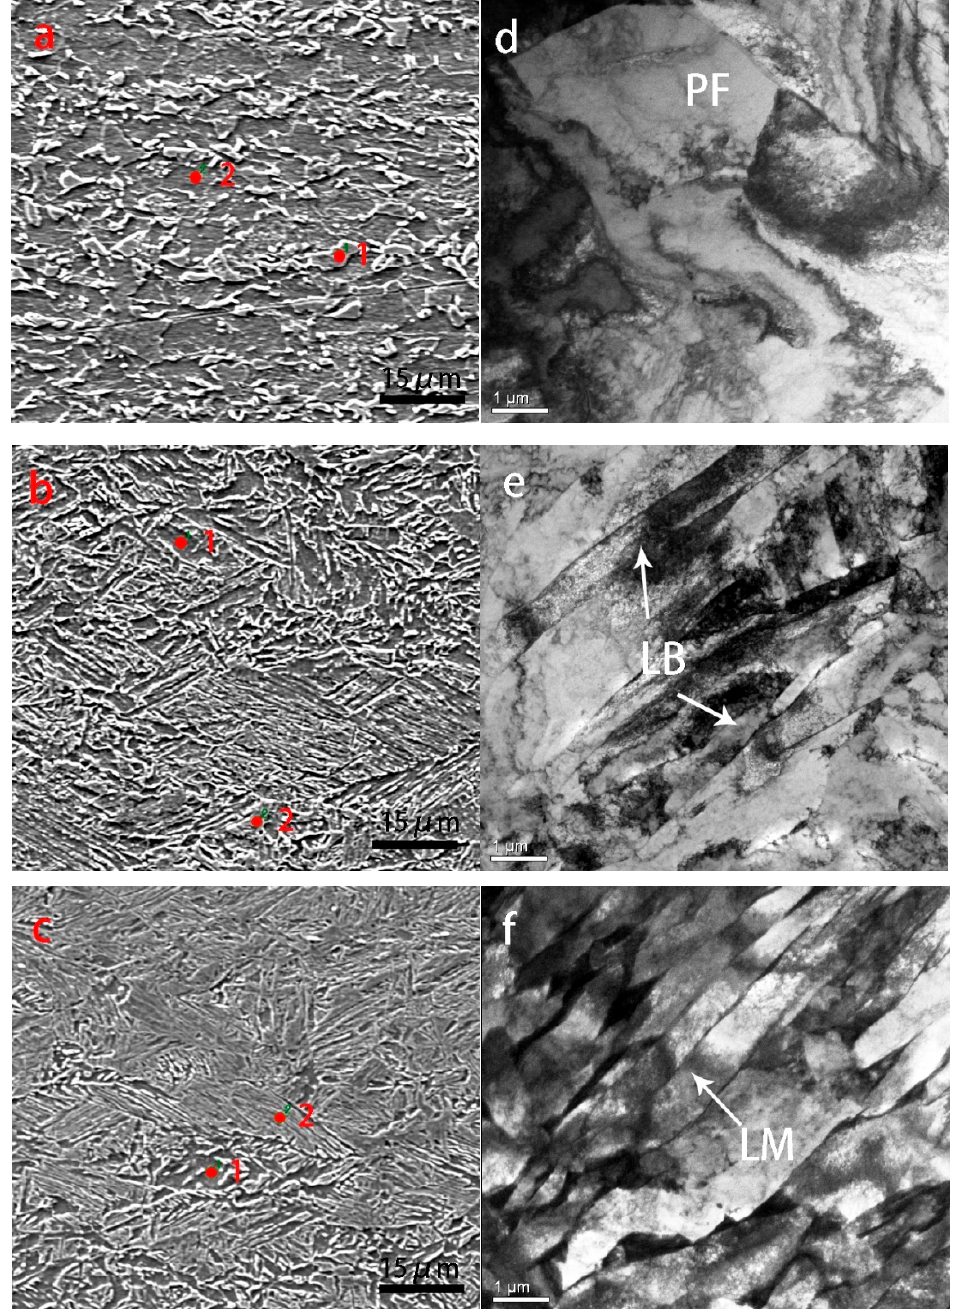
Figure 6. Measurements of segregated spots in the segregated area by an electron probe micro-analyzer and a transmission electron microscope: ( a ) And ( d ) for sample B-4#, ( b ) and ( e ) for sample A-4#, ( c ) and ( f ) for sample A-2#. Table 2. Alloy component in the segregated region measured by electron probe micro-analyzer (wt.%).